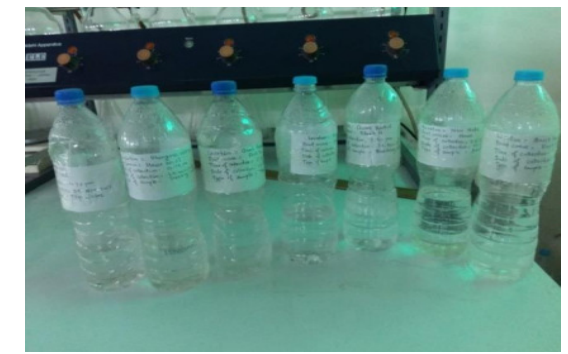
Fig. 1: Different Samples of Drinking and Tap Water Table 1: Sampling Location Names